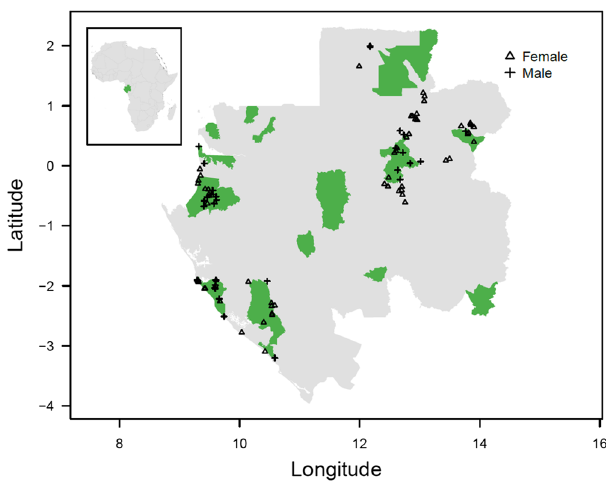
Figure 1. Map of the study area. The inset denotes the location of Gabon (green) within Africa; the main map shows mainland Gabon (grey); the distribution of protected areas (green); and the first GPS location of each elephant by sex in the dataset (black points; n = 96). The map was generated with R version 4.0.3 (https:// www.r- proje ct.